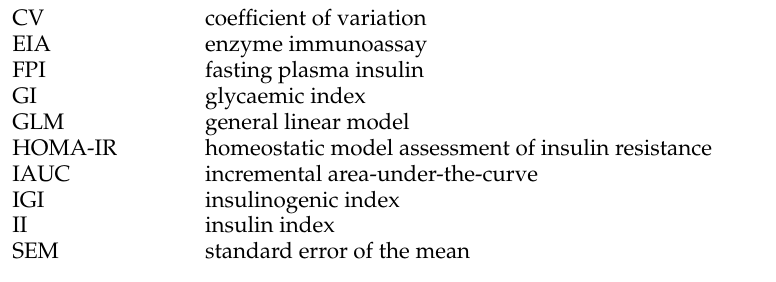
Table S1: Postprandial plasma motilin, neuropeptide-Y and orexin-A responses (ng/mL) at baseline and 2 h post-consumption of test rice and glucose standard (mean ˘